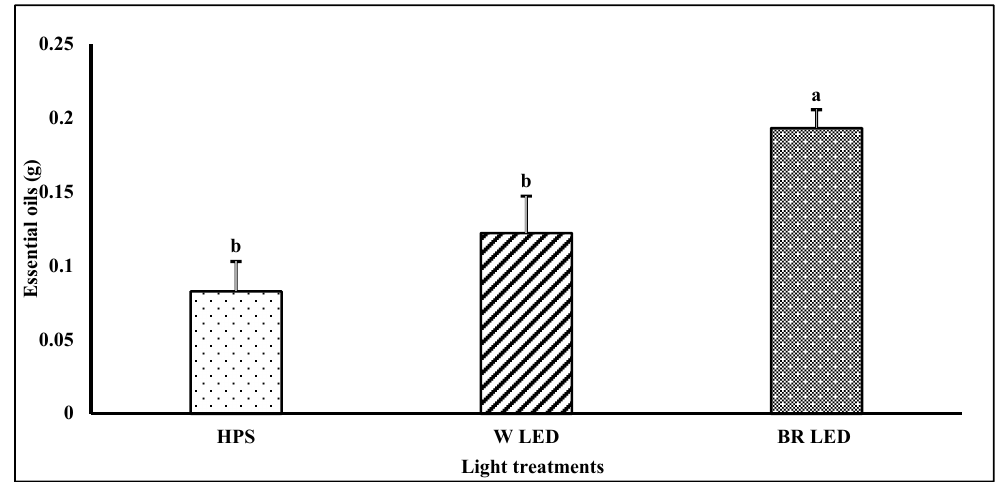
Figure 9. The effect of light treatments on the yield of essential oil in sweet basil (LSD = 0.049). Different letters denote significant differences between treatments ( p < 0.001).